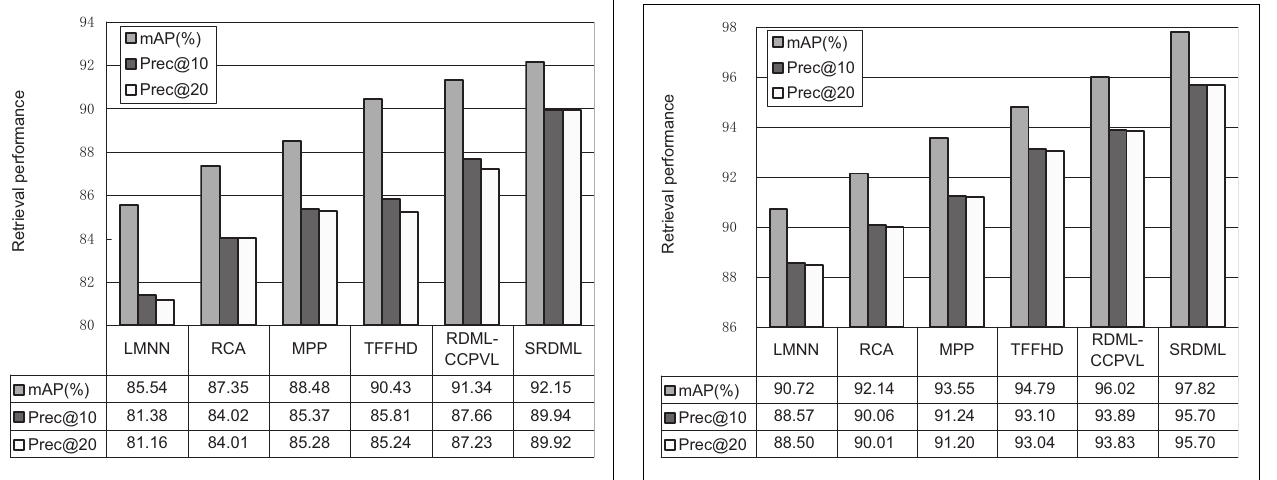
FIGURE 5 | Retrieval performance comparisons in Meningioma. FIGURE 6 | Retrieval performance comparisons in